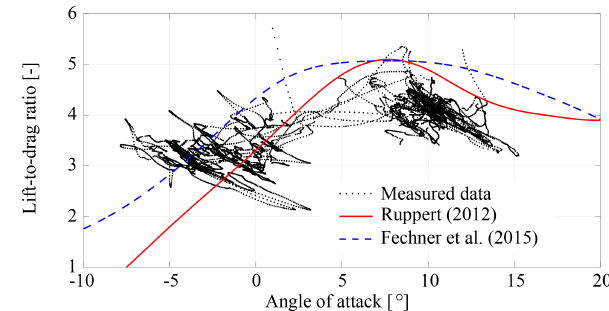
Figure 17. Comparison of measured lift-to-drag ratio with existing aerodynamic correlations. Table 2 filters no. 1, no. 2 and no. 3 have been applied.